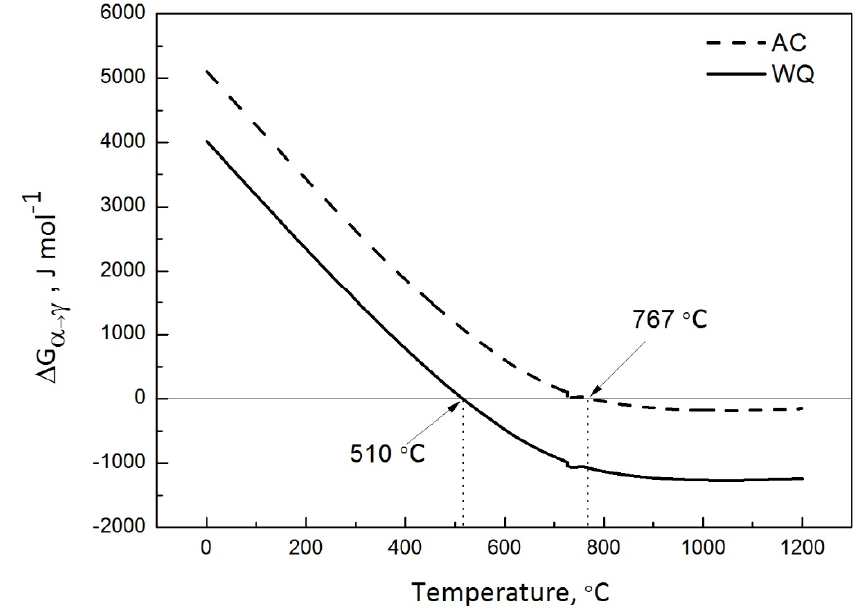
Figure 10. Driving force (molar Gibbs free energy change) for on-heating ferrite to austenite transformation calculated using ThermoCalc. AC is for air-cooled initial microstructure; WQ is for water-quenched initial microstructure.